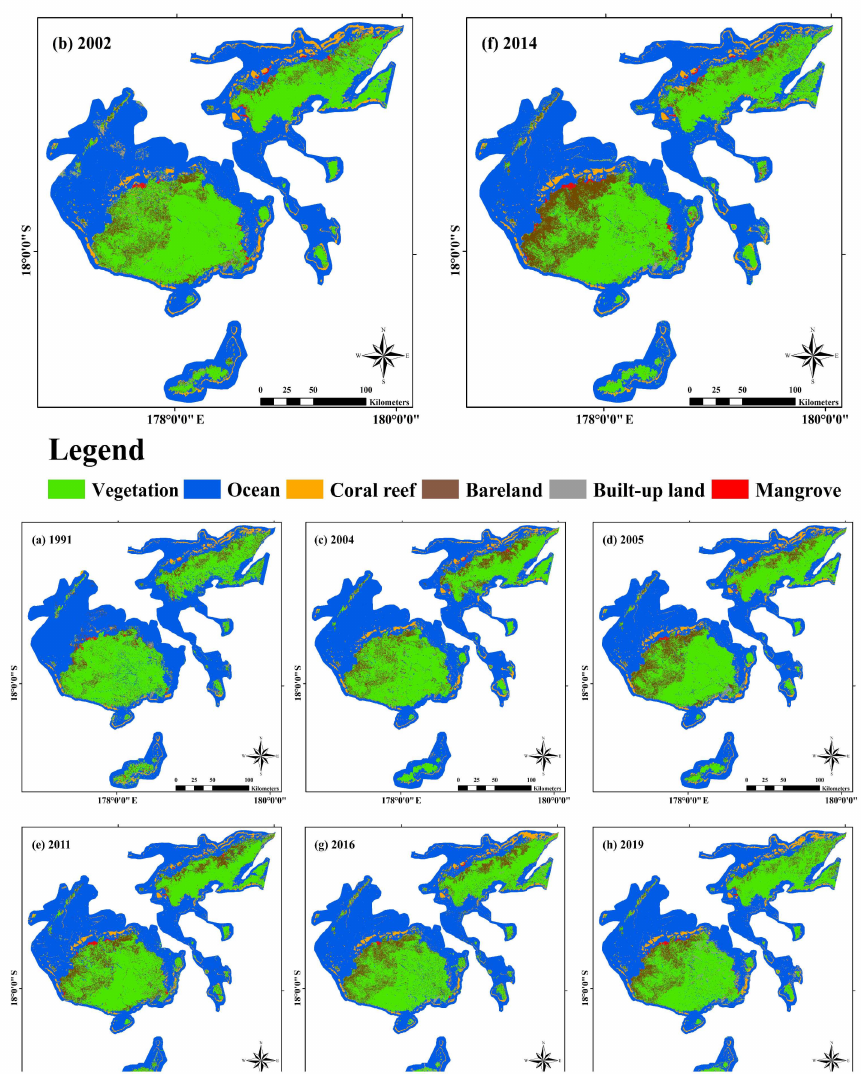
Figure 2. Types of land use in Fiji from 1991 to 2019: ( a ) 1991; ( b ) 2002; ( c ) 2004; ( d ) 2005; ( e ) 2011; ( f ) 2014; ( g ) 2016; ( h ) 2019. (Years 2002 and 2014 were selected for enlarged maps because they mark two important turning periods of land-use change in Fiji. Images in 1991 had relatively large cloudiness, which affected the statistics of coral reef area; thus, the statistics of coral reefs area in 1991 were not considered in this